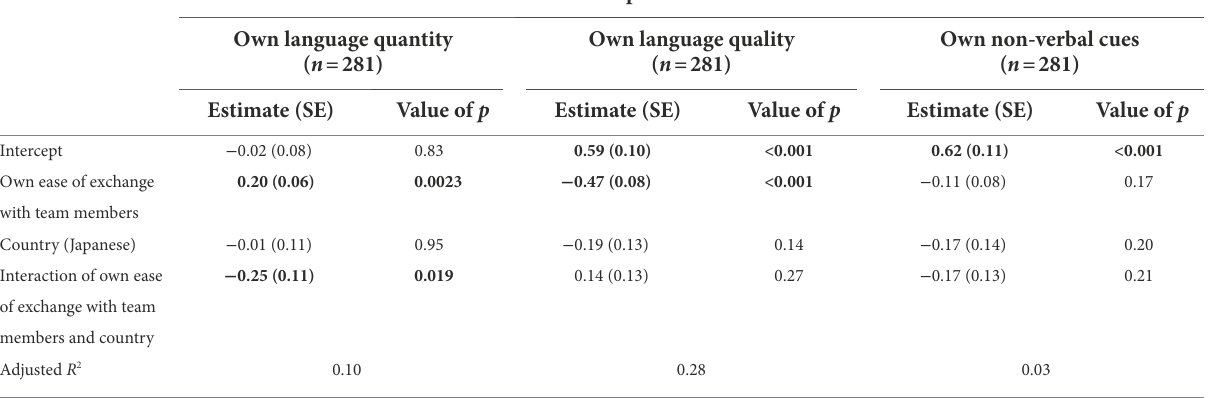
TABLE 8 The linear regression models predicting educators’ own communicative behavior toward